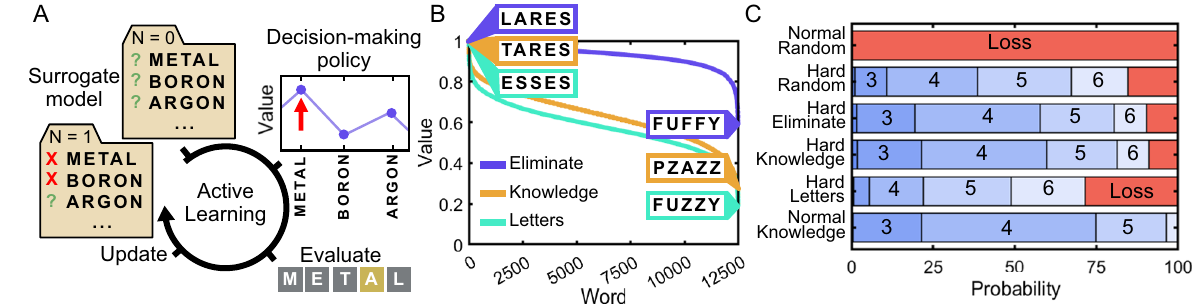
Fig. 1 Playing Wordle using active learning. A Diagram showing the anatomy of active learning in a game of Wordle. A surrogate model describes the present belief about the system. During the fi rst turn ( N = 0), all words are assumed to be candidates for the winning word. Next, a decision-making policy is employed to quantify the relative value of each word. Subsequently, the highest value word is guessed and the response is used to update the surrogate model. This process continues until the correct word is found or the player loses. B Ranked order evaluation of three decision-making policies for all words. Decision policies include ‘ Eliminate ’ in which each word ’ s value is estimated by the number of words that could be eliminated if it was guessed, ‘ Knowledge ’ in which the value of each word is determined by the number of unique outcomes that could arise from guessing the word, and ‘ Letters ’ in which the value of each word is based on the abundance of its letters in the catalog of words. C Probability of different outcomes from playing Wordle guided by different strategies. Color indicates the number of guesses required to fi nd the correct answer with red indicating that seven or more guesses were required. Strategies are either ‘ Hard ’ in that they require that words are selected from those that have not been ruled out or ‘ Normal ’ in that all words can be selected. ‘ Random ’ indicates that words were selected uniformly at random. The code used to produce these results can be found at https://github.